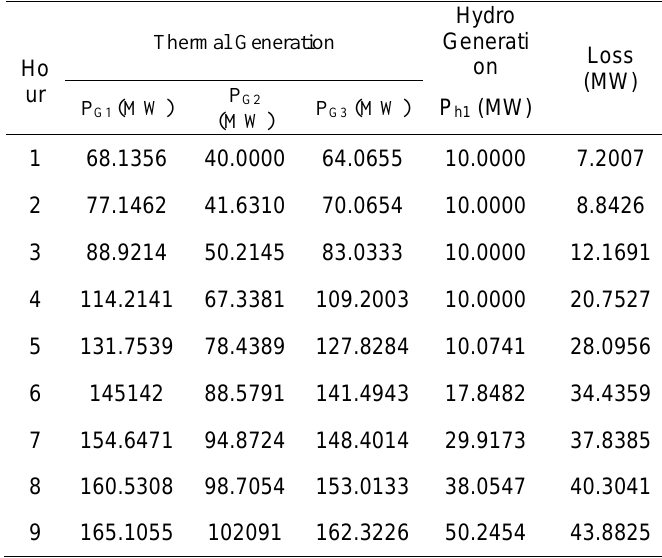
Figure1. reflects that the system demand over one day scheduling period and it attains maximum in 13 th hour. For hydro units the corresponding power generation limits and water availability and its discharge rate coefficients are calculated in table -3